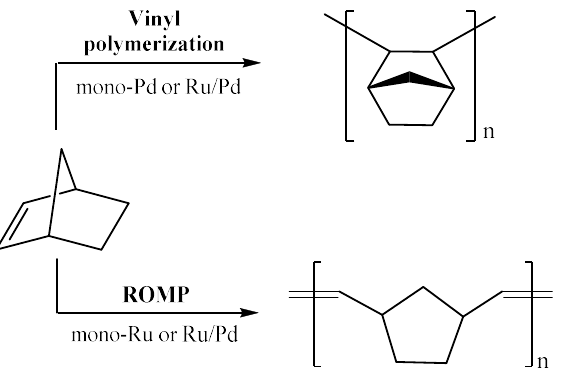
Figure 3. Cyclic voltammogram of Ru–Pd obtained in n -Bu 4 NPF 6 /CH 2 Cl 2 0.1 mol L − 1 vs. Ag/AgCl at a scan rate of 100 mV s − 1 ; [Ru/Pd] = 1.0 × 10 − 3 mol L − 1 .